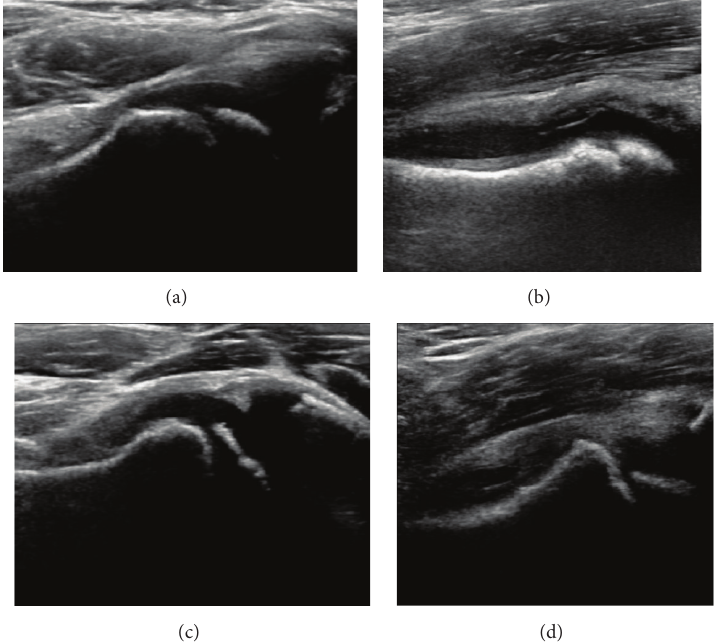
Figure 12: (a) Normal ultrasound appearance of the femoral head-neck junction. (b) Joint effusion in transient synovitis of the hip. (c) Flattening of the femoral head in a patient with Perthes disease. (d) Step in the femoral head-neck junction in a patient with